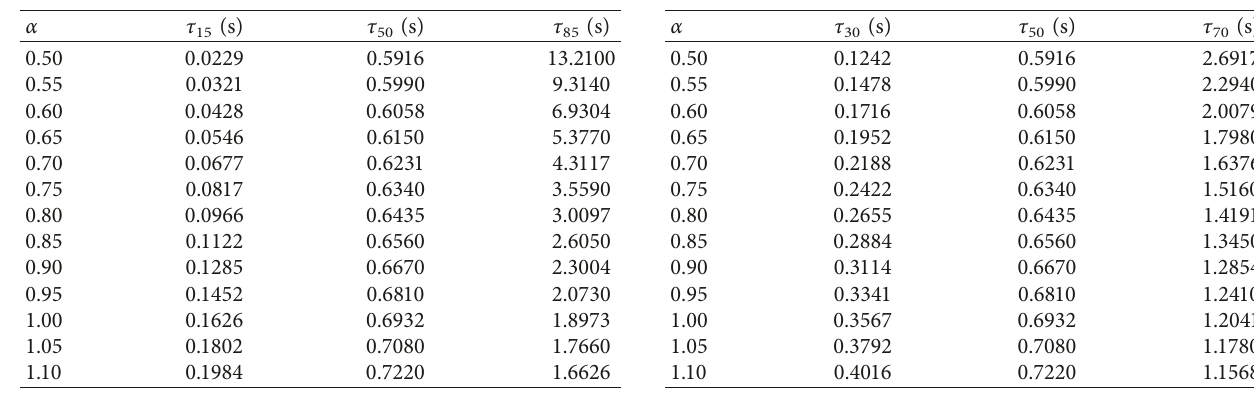
20 , τ 50 , and τ 80 for